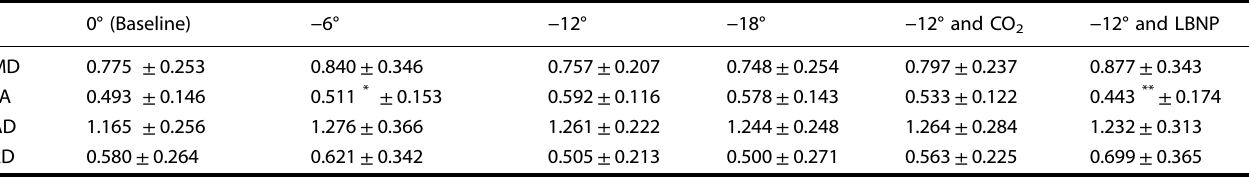
Table 2. Mean diffusivity (MD), fractional anisotropy (FA), axial diffusivity (AD), and radial diffusivity (RD) of the optic nerve 0° (Baseline)